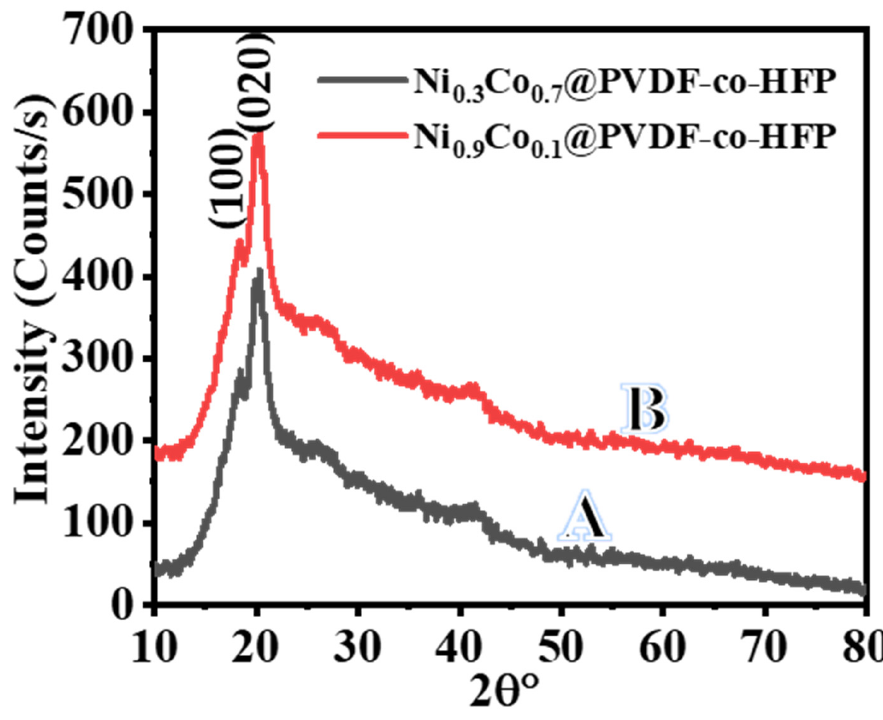
Figure 4. XRD patterns of Ni 0.3 Co 0.7 @PVDF ‐ co ‐ HFP (A) and Ni 0.9 Co 0.1 @PVDF ‐ co ‐ HFP (B) NF mem ‐ branes.